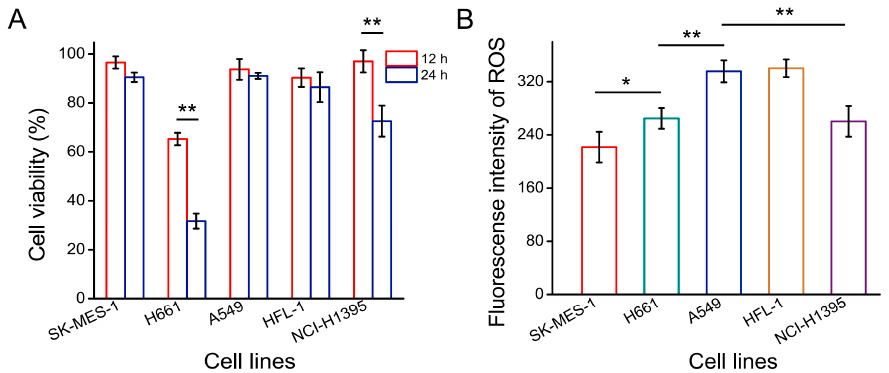
Figure 1. ( A ) Cell viabilities of the five lung cancer cell lines treated with PQ. Results were expressed as percentage compared with each control group under different treatment time, and the cell viabilities of all the control groups were set to 100%. ( B ) Fluorescence intensity values of ROS in different cell lines treated with PQ. The fluorescence intensity of control group was used as a background baseline. * means p < 0.05 and ** means p < 0.01. All experiments were repeated three times and results were expressed as means ±